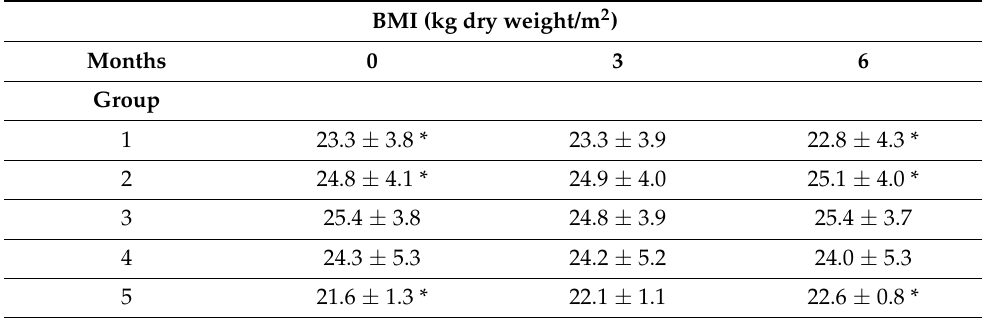
Table 2. Body mass index BMI (kg/m 2 ) in patients in each group before and after nutritional therapy (mean ± SD).